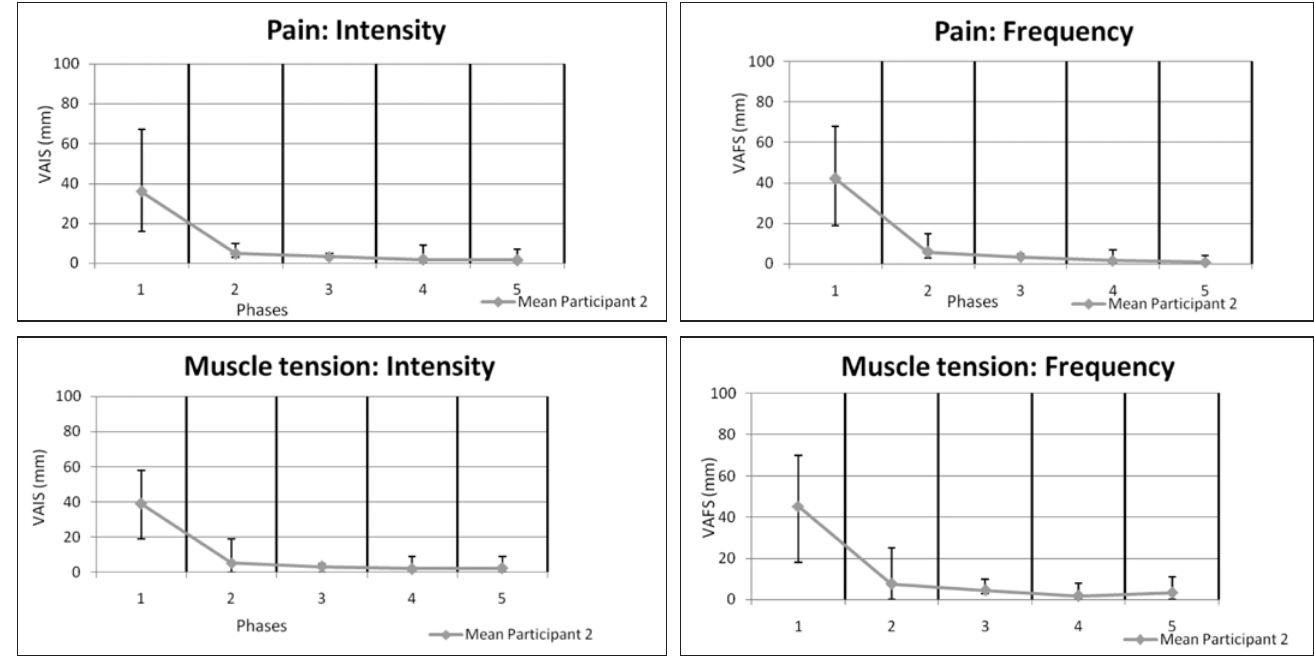
Figure 3: Graph depicting mean values for VAS outcomes for Participant 2 showing variability of data for each